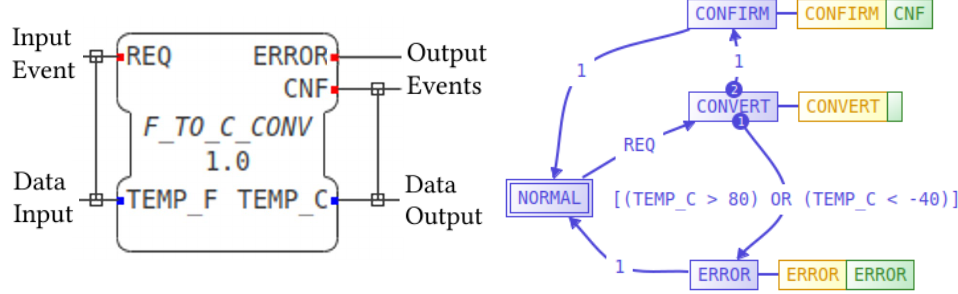
Figure 2. IEC 61499 Function Block that converts temperatures with its